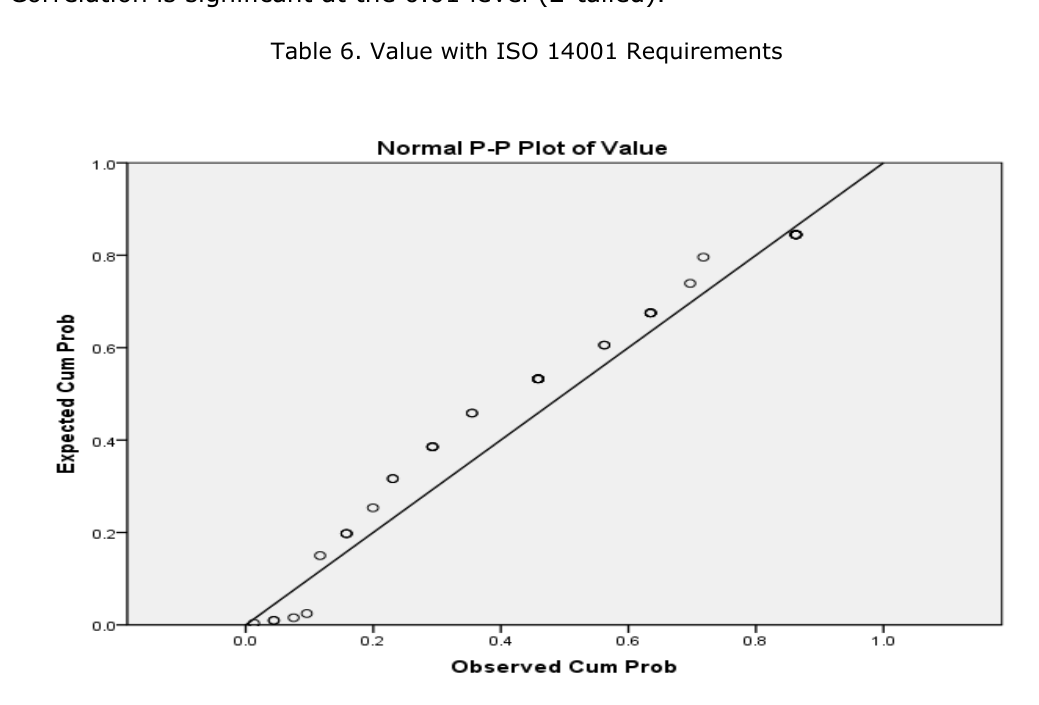
Figure 2. Lean Principles “Value” against ISO 14001